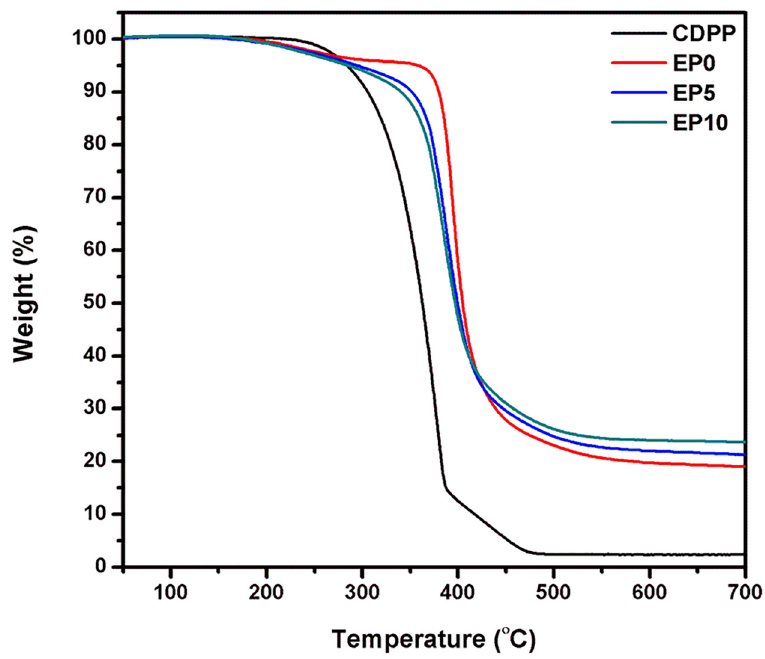
Figure 4. TGA curves of CDPP and EP series in nitrogen atmosphere.